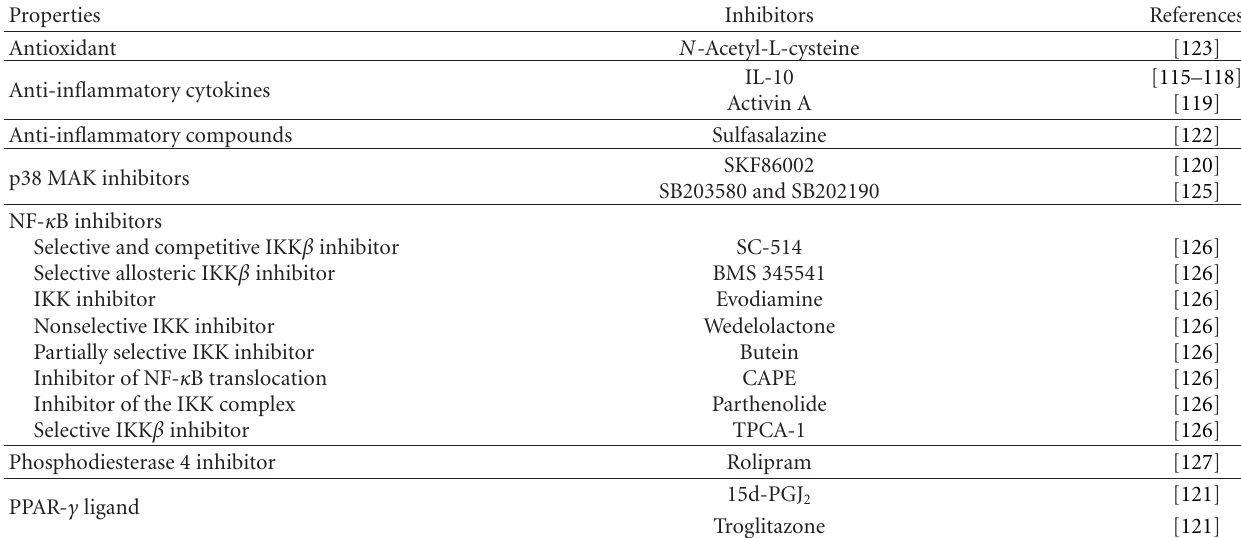
Table 5: Physiological and pharmacological inhibitors for cytokine production in human fetal